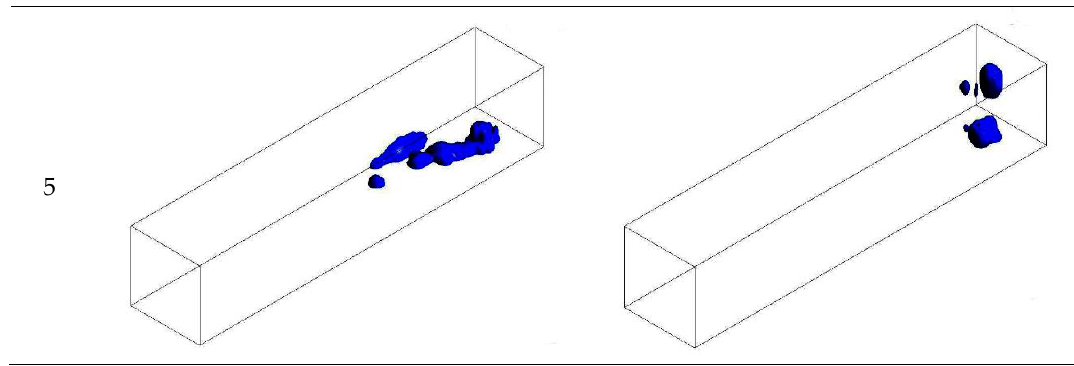
Figure 21. Time evolution of water transport (All the surfaces contact angles are 45° and all the surfaces contact angles are 135°).